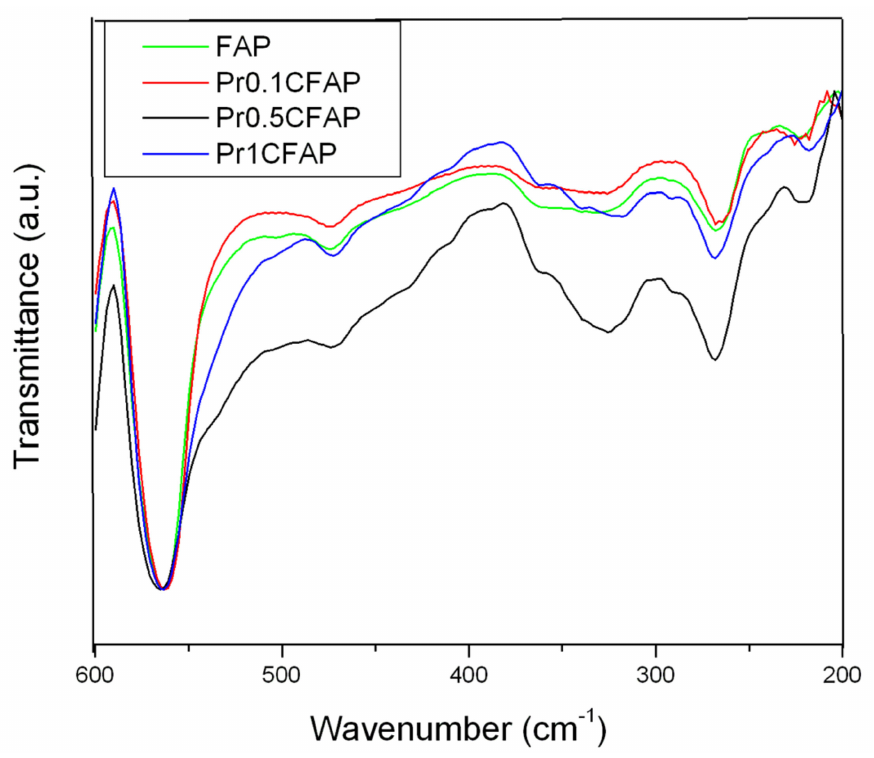
Figure 3. FIR transmittance spectra of FAP and Pr x CFAP samples. Table 3. FIR vibration bands for FAP and Pr x CFAP